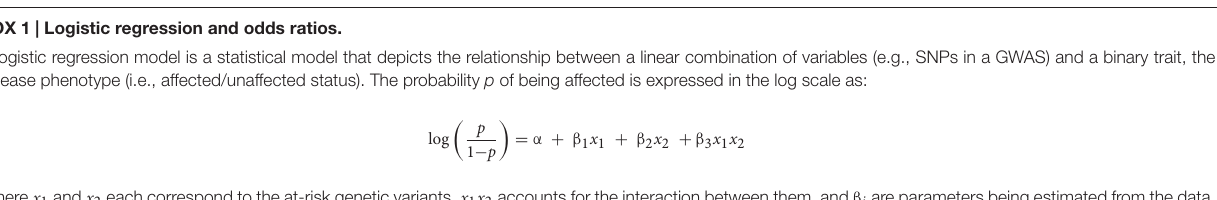
BOX 1 | Logistic regression and odds ratios.